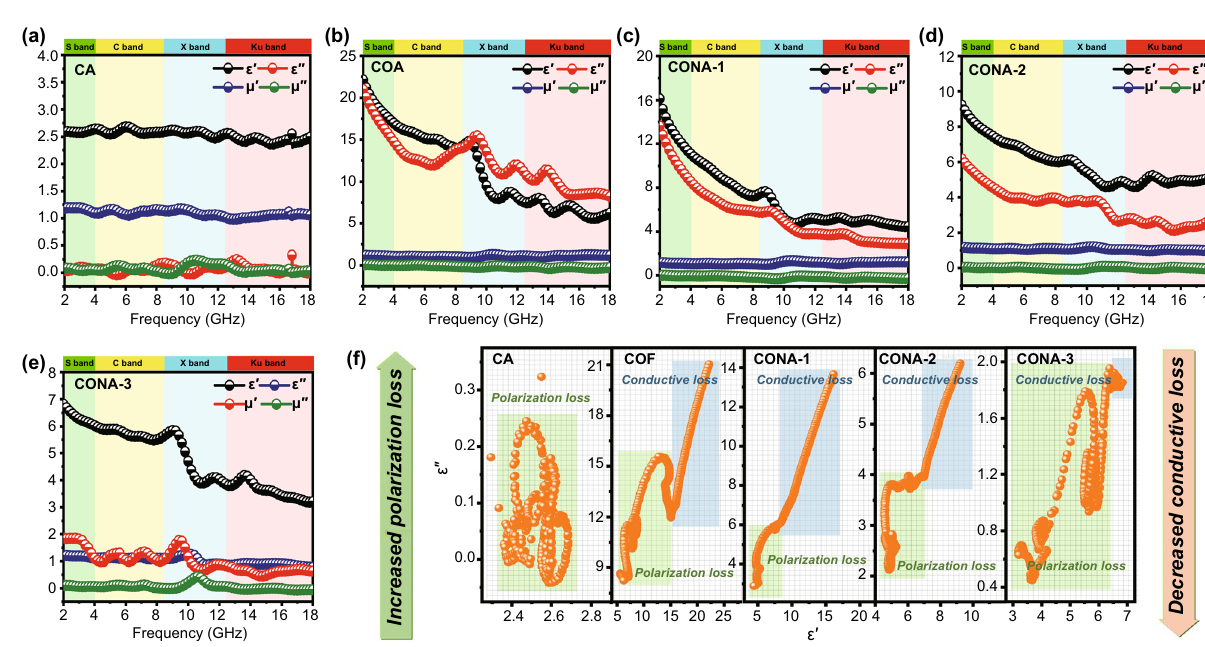
Fig. 4 EMW parameters of a CA; b COA; c CONA-1; d CONA-2; e CONA-3. f Cole–Cole semicircle of